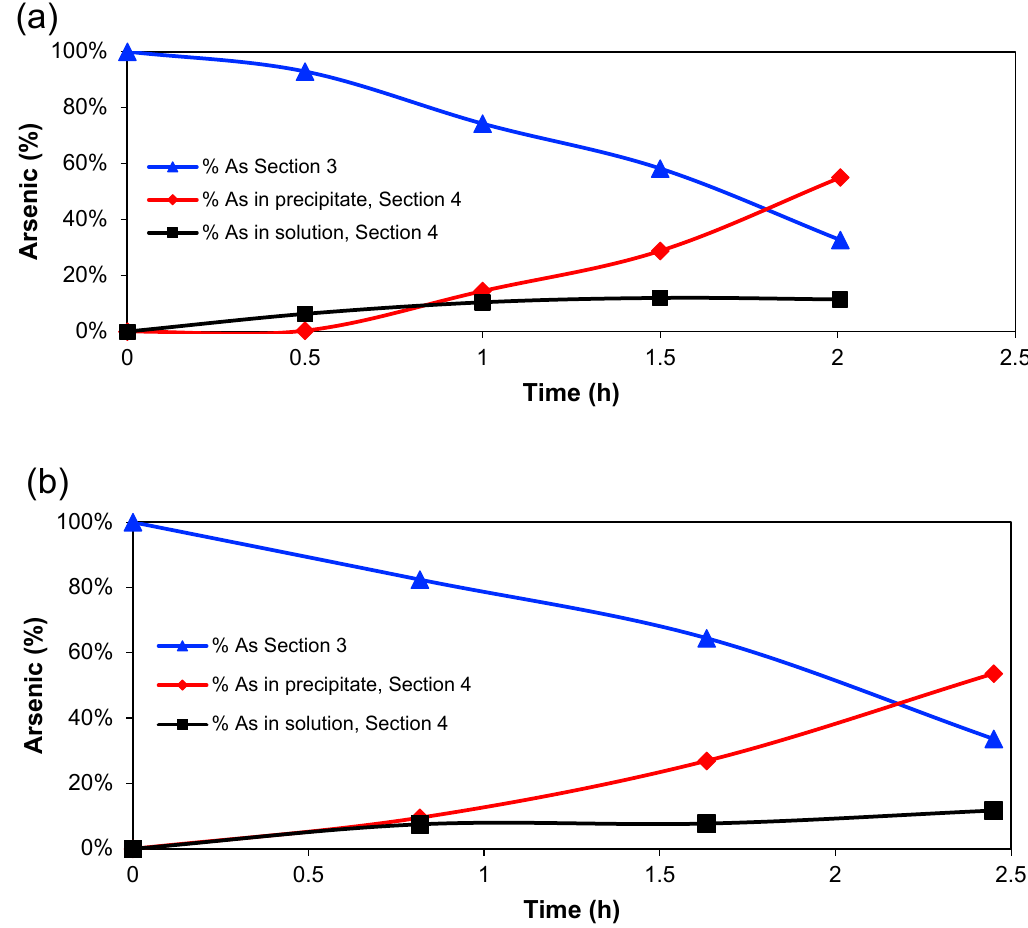
Figure 3. Percentage of arsenic in Sections 3 and 4 over time ( a ) Series 1, ( b ) Series 2.